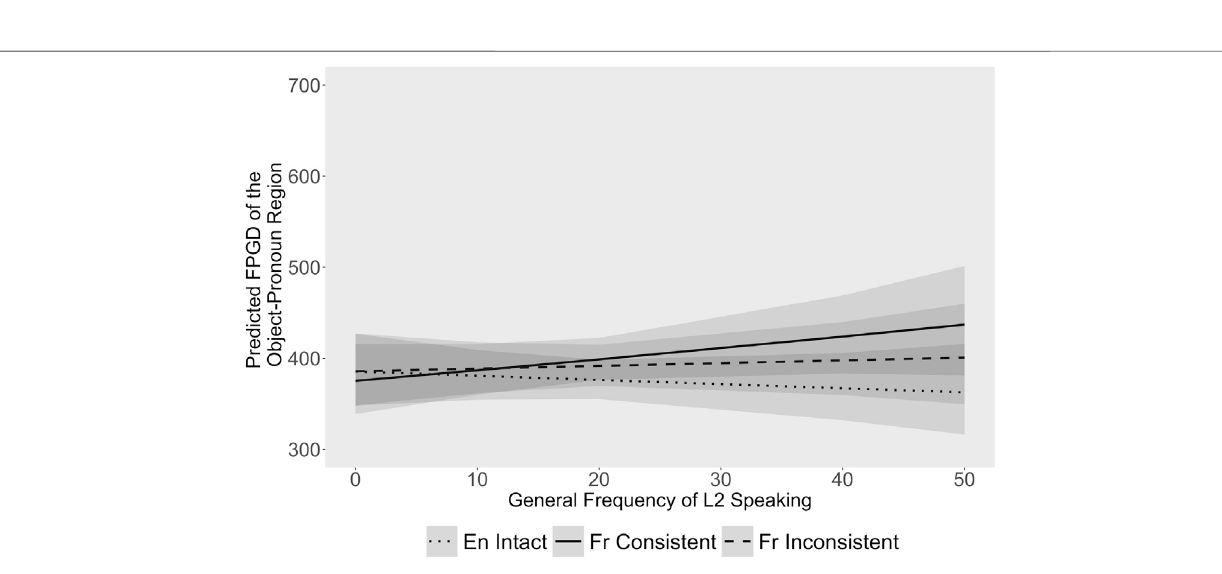
Frontiers in Communication |